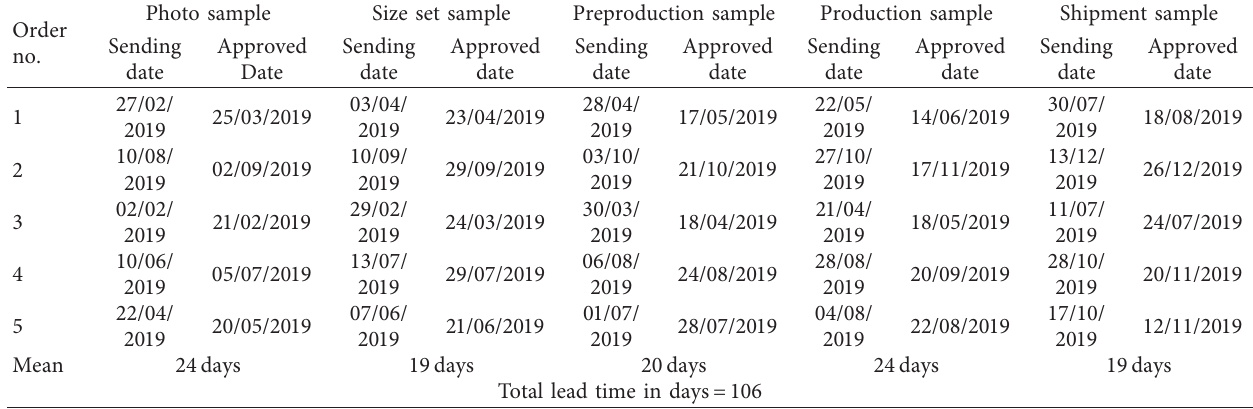
Table 4: Company D, date-wise sample approval data taken from five different orders.